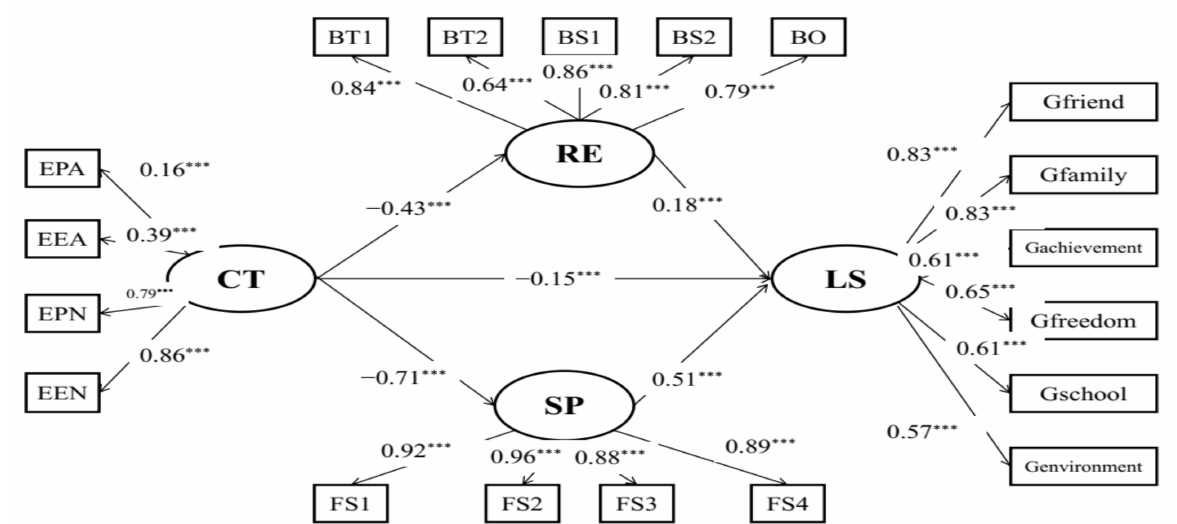
Figure 3. Mediation model of child maltreatment, life satisfaction, resilience, and social support.